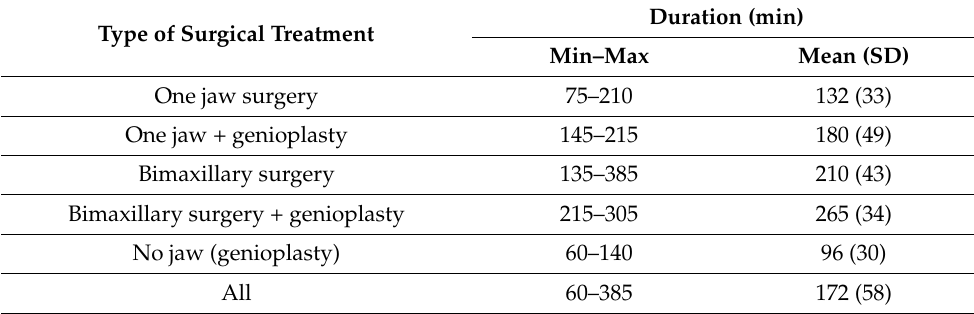
Table 10. A detailed breakdown of the correlation between the duration of surgery and the type of surgical treatment in the study group of patients